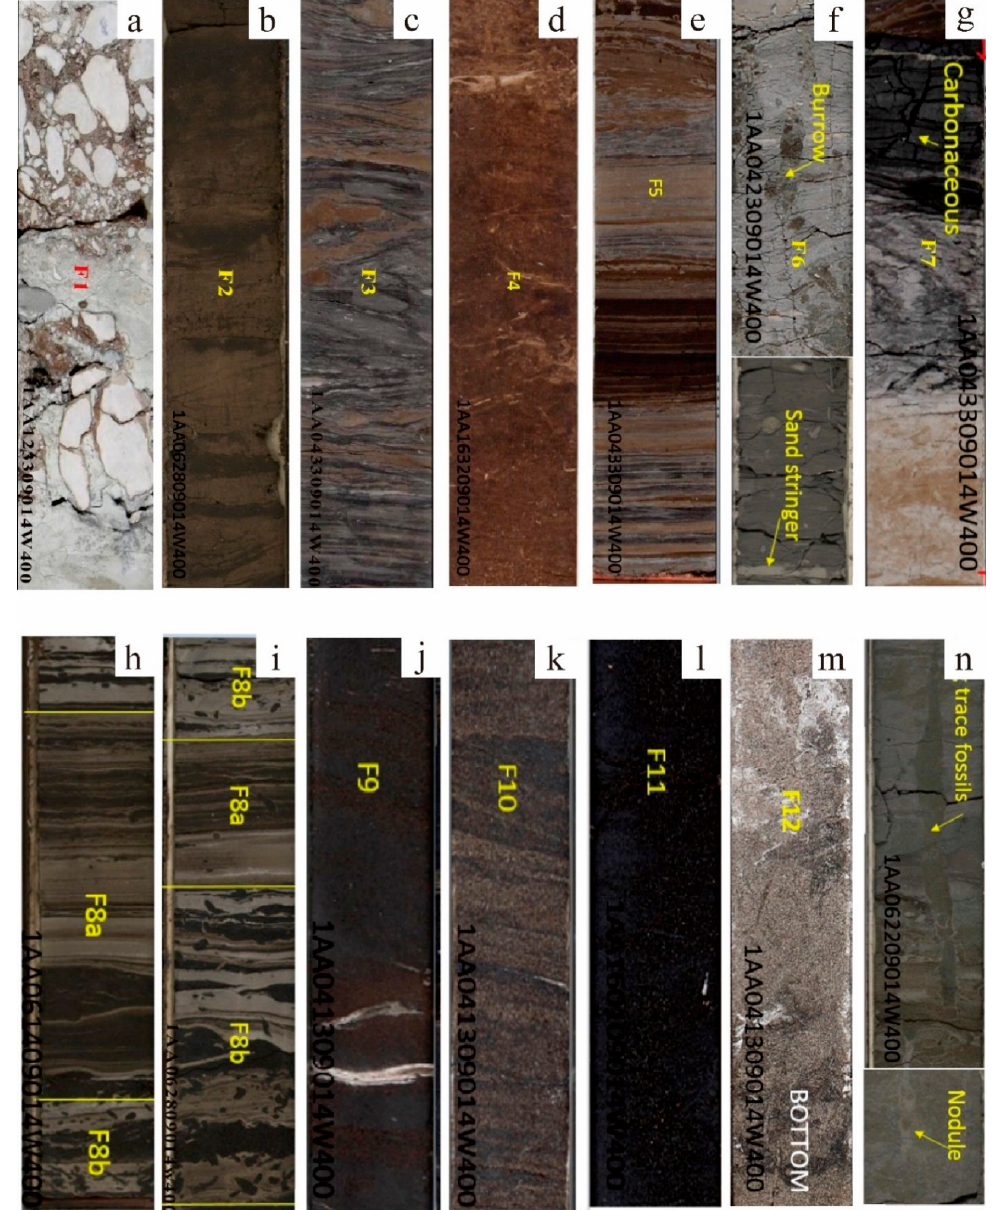
Figure 4. Photographs of typical sedimentary characteristics of thirteen facies in the McMurray